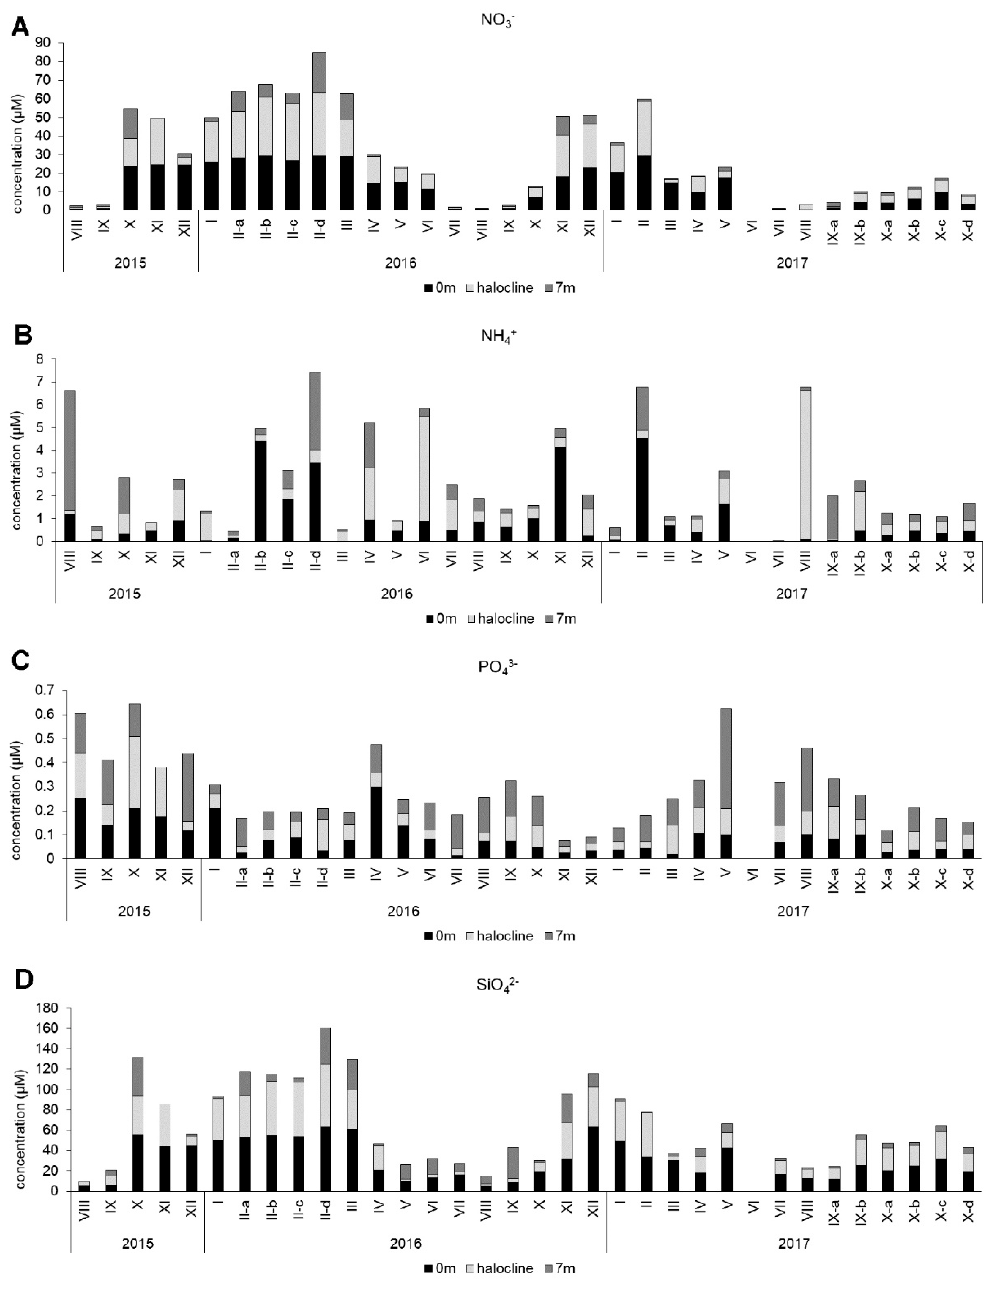
Figure 9. Nutrient concentrations of ( A ) nitrates, ( B ) ammonia, ( C ) orthophosphates, and ( D ) orthosilicates throughout the study period at Strmica station.